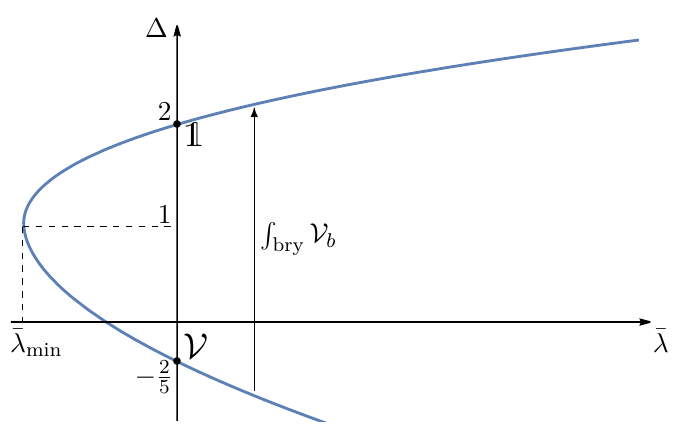
Figure 33. Sketch of the scaling dimension of the first boundary operator (above the identity) for the scaling Lee-Yang model in AdS . At λ = 0 , the bulk theory is conformal and the two black dots 2 correspond to the two possible BCFTs (labeled by 1 and V ) for the Lee-Yang minimal model. We conjecture that the two curves merge (smoothly) at ¯ λ = ¯ λ 0 . 5 and ∆ = 1 (see figure 21). min ≈ − We expect that ∆ becomes complex for ¯ λ < ¯ λ similarly to what happens for complex CFTs [65]. min There is also a boundary RG flow generated by the relevant boundary operator with ∆ < 1 that goes from the lower to the upper curve.